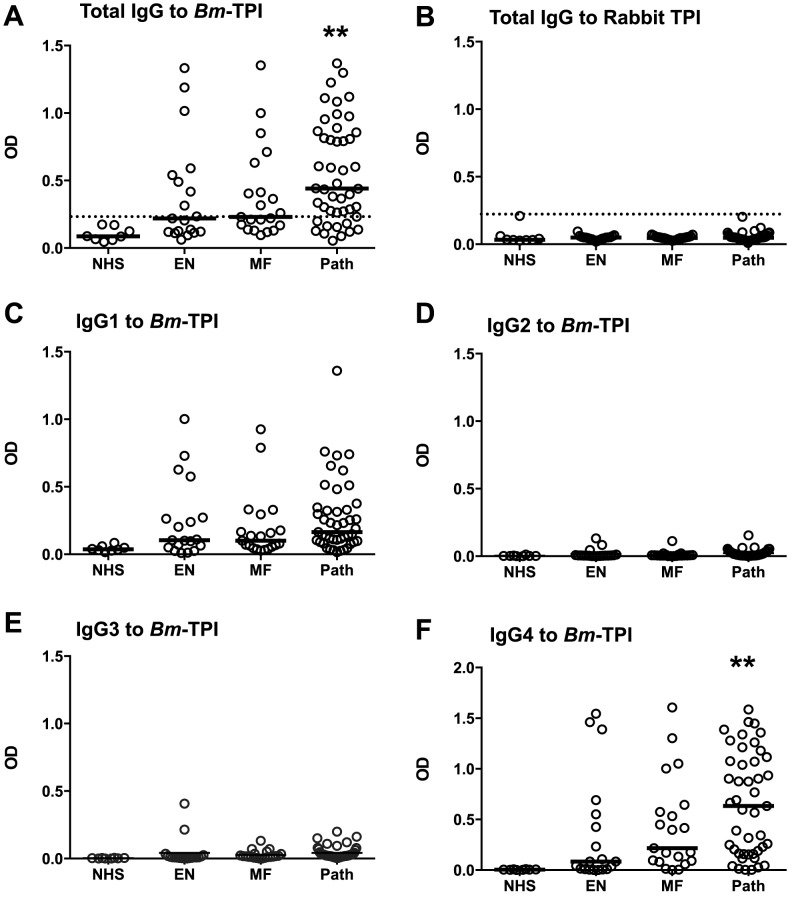
Anti-Bm-TPI antibody levels in B. malayi-infected human filariasis patients.
A. Human anti-Bm-TPI IgG levels measured by ELISA (OD values). Each data point represents an individual normal human serum (NHS) or serum from filariasis-exposed subjects classified as endemic normal (EN), microfilaraemic (MF) or chronic pathology (Path). B. IgG ELISA responses of the same patient groups to mammalian (rabbit) TPI. C–F. IgG1-IgG4 isotype-specific anti-Bm-TPI levels in the same patient groups. ** p<0.01, significance compared to NHS by ANOVA. Lines in (A–F) represent median values.